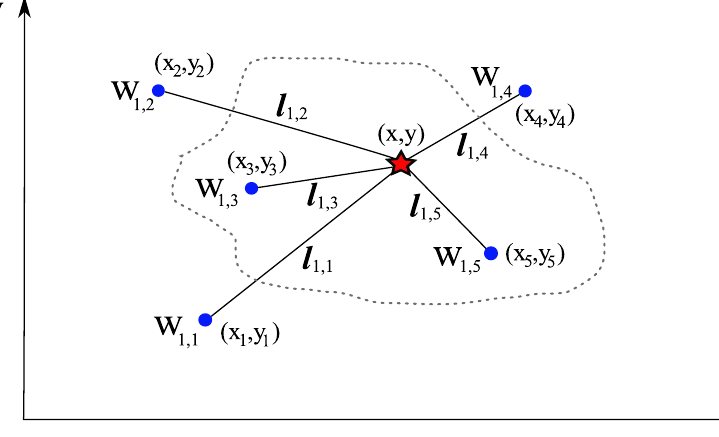
Figure 3. An example of the location of five points of consumption (blue circles), given by Cartesian coordinates and the best position of the ship (asterisk) for unloading by a helicopter taking into account the position constraints of the vessel (the vessel is inside the area bounded by a dashed